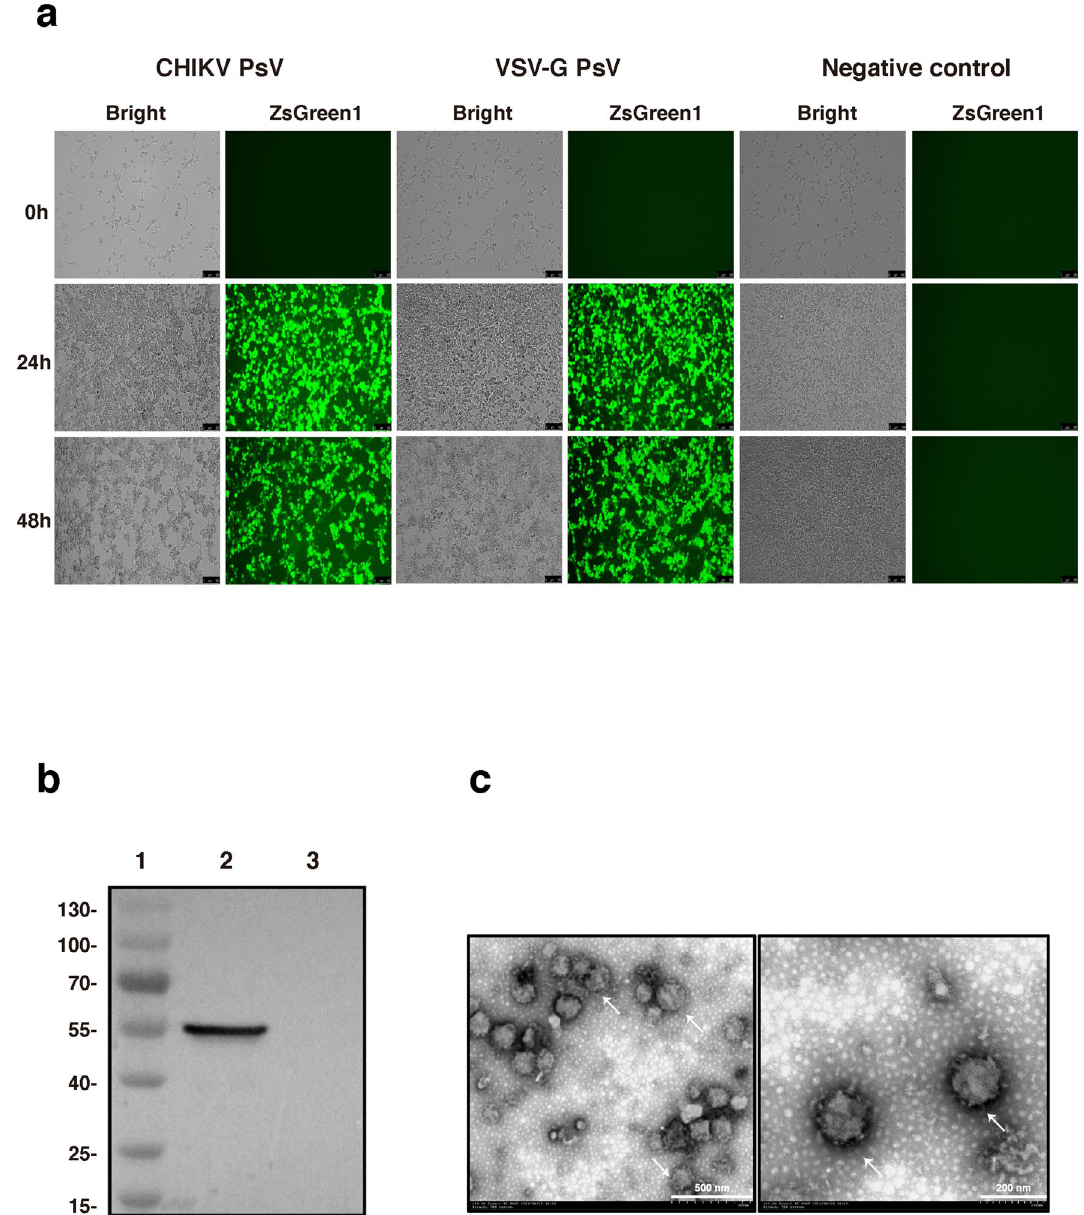
Figure 2. Formation of CHIKV PsV particles. ( a ) Three plasmids (PsPAX2, pLVX-IRES-ZsGreen1-Luc, and pMD2.G-CHIKV-env or pMD2.G) were co-transfected into 293T cells. At the indicated time points, fluorescence was observed under the microscope to monitor the transfection efficiency. ( b ) The PsV particles concentrated by ultracentrifugation were analyzed by Western blotting using mouse Monoclonal antibody against E1. 1: 180 kDa protein marker; 2: the lysate of CHIKV PsVs; 3: the lysate of VSV-G PsVs. Unprocessed images can be found in supplementary information Fig. S1. ( c ) CHIKV PsV particles was stained with phosphotungstic acid and observed under transmission electron microscopy. The scale bars represent 500 nm (left) and 200 nm